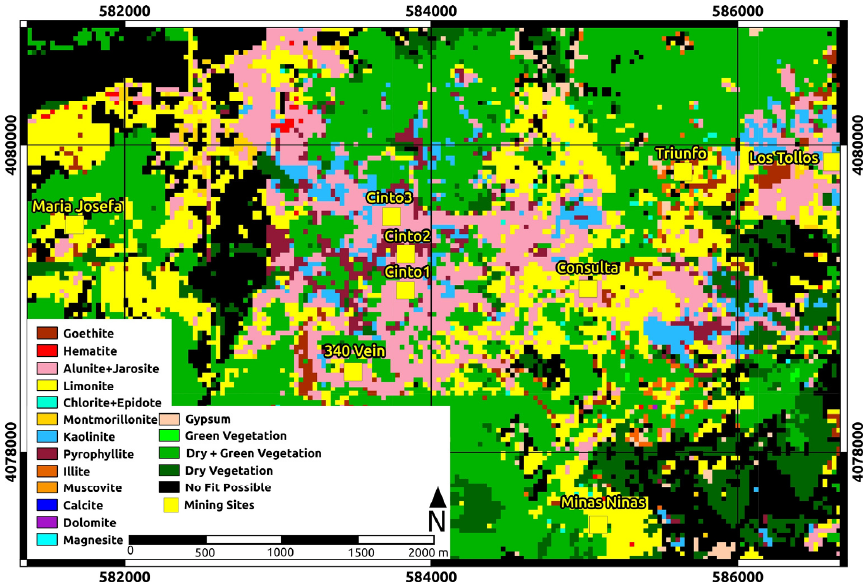
Figure 8. EnGeoMAP 2.0 best fit material map calculated from simulated EnMAP data, using sensor dependent absorption depth thresholding. Note the main advanced argillic alteration characterized by alunite and jarosite in the image center. Please also note the large abundance of alunite and jarosite to the east at Los Tollos.